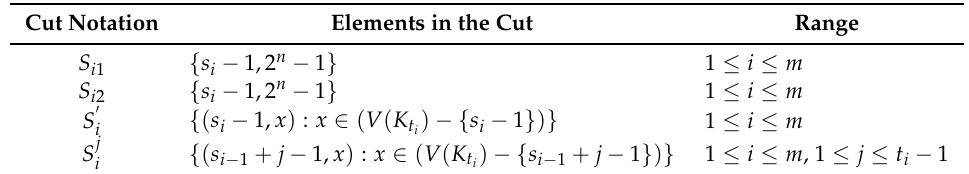
Table 2. Edge cuts in complete star necklace